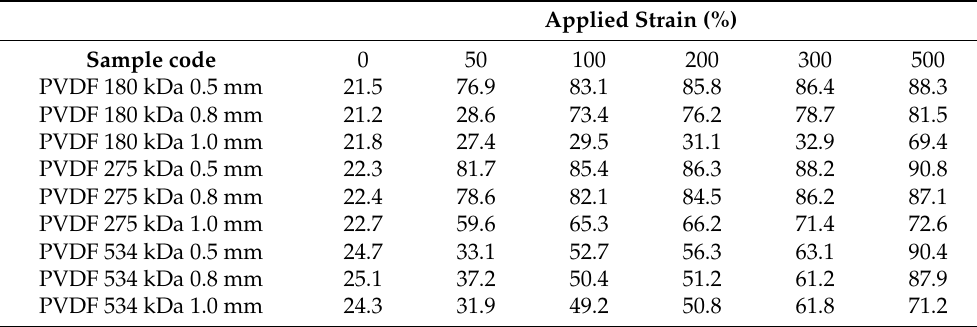
Table 2. Summarized values of the β -phase content (F( β )) calculated according to Equation